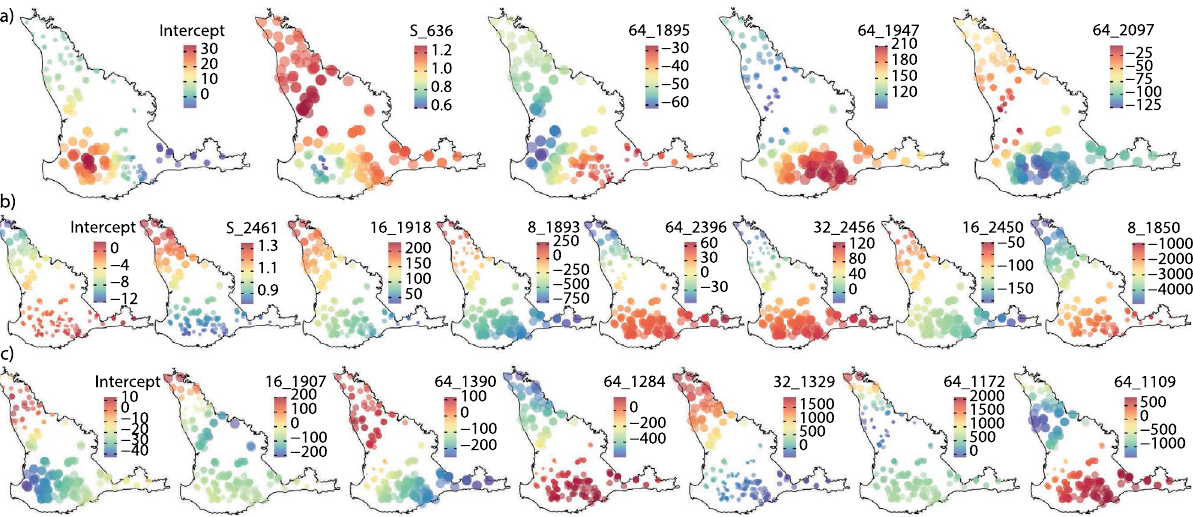
Figure 5. Distributions of local coefficients of wavelets in WGWR of soil organic carbon ( a ), clay ( b ), and pH values ( c ). Sizes of points indicate absolute values of